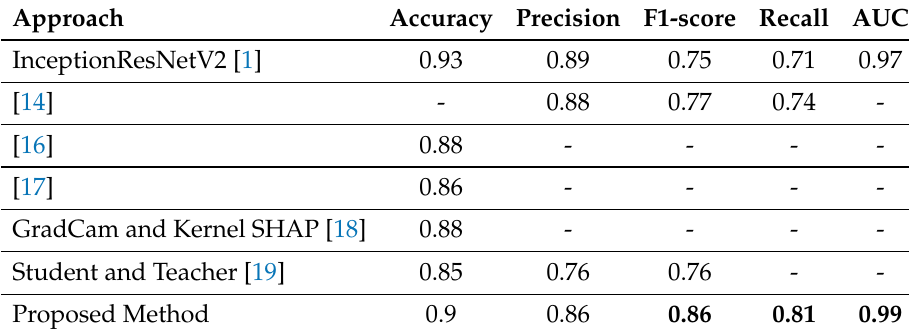
Table 9. Comparative Analysis. Bold numbers highlight the highest performance.